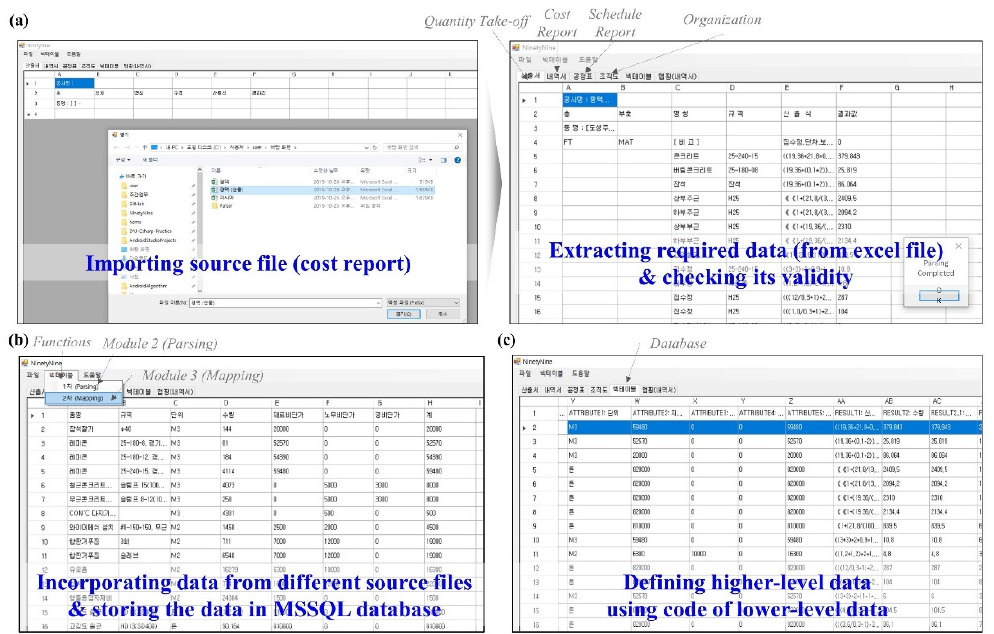
Figure 6. Interfaces of Module 1, 2, and 3 implemented using Python, ( a ) Module 1 for Automatic Text Mining, ( b ) Module 2 for Data Parsing, and ( c ) Module 3 for Metadata Mapping.